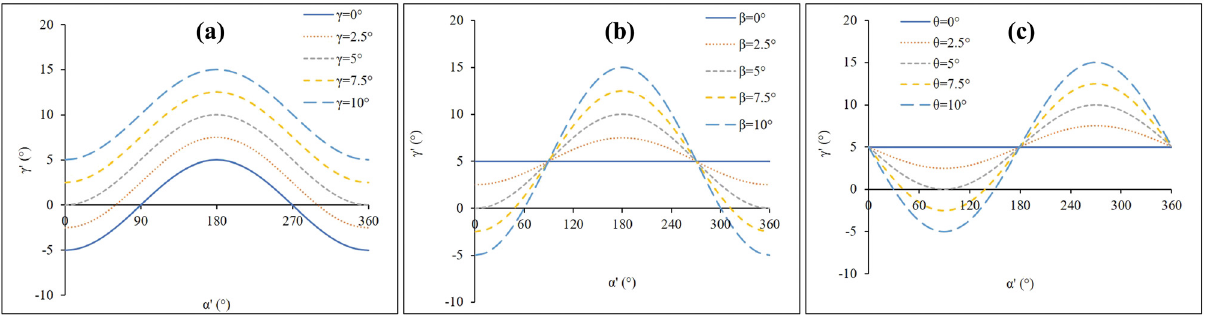
Figure 5: The ppRPE/BM layer angle γ ′ variation across the radial directions was in fl uenced by ( a ) the ppRPE/BM layer 3D angle γ ( constant β = 5° ) , ( b ) the tilt angle β ( constant γ = 5° ) , and ( c ) the tilt angle θ ( constant γ = 5° ) . The remaining parameters are